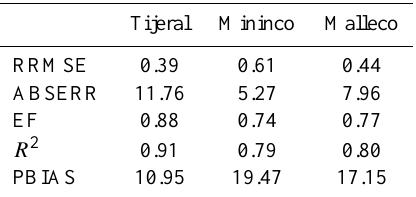
Table 11. RMS error, absolute error, efficiency, determination coef- ficient and percentage of Bias calculated for the period